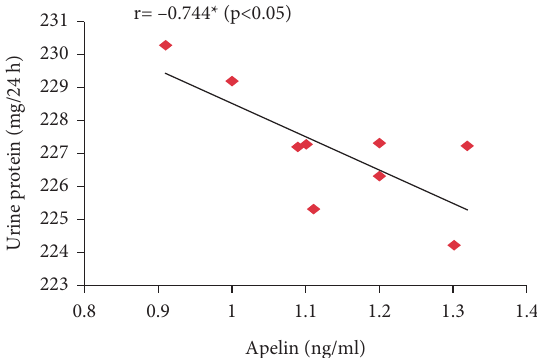
Figure 8: Correlation between serum apelin level and total urine proteins in the PE